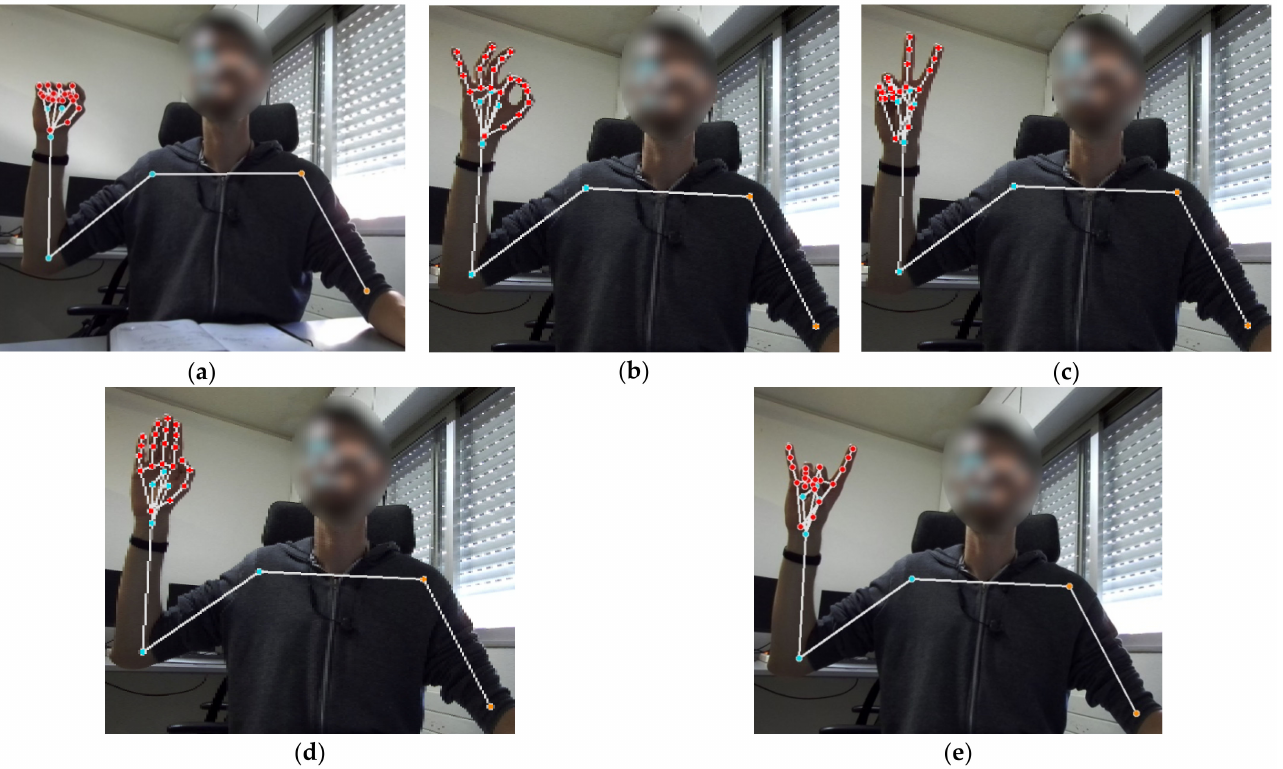
Figure 2. Tracked hand landmarks denoted by dots for the gestures: ( a ) “fist”, ( b ) “ok”, ( c ) “victory”, ( d ) “flat”, and ( e ) “rock”.